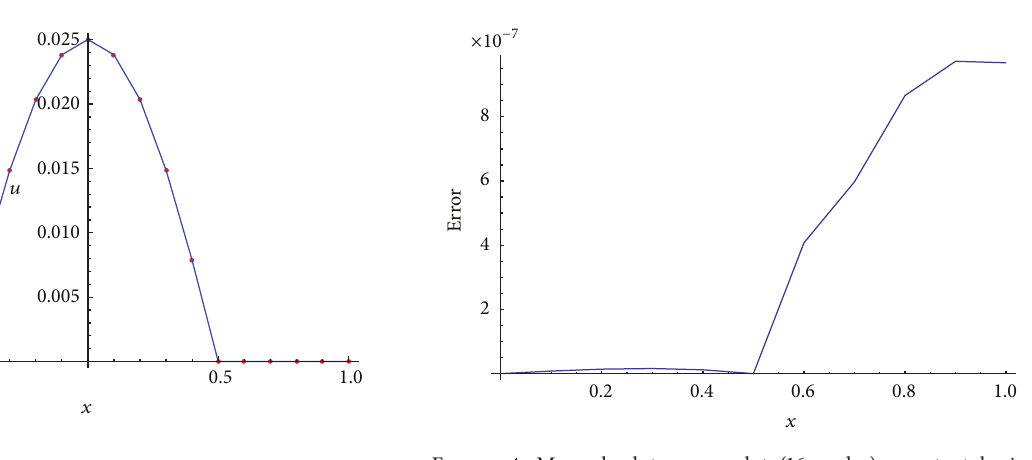
Figure 4: Max. absolute error plot (16 nodes), constant basis- Problem 1.